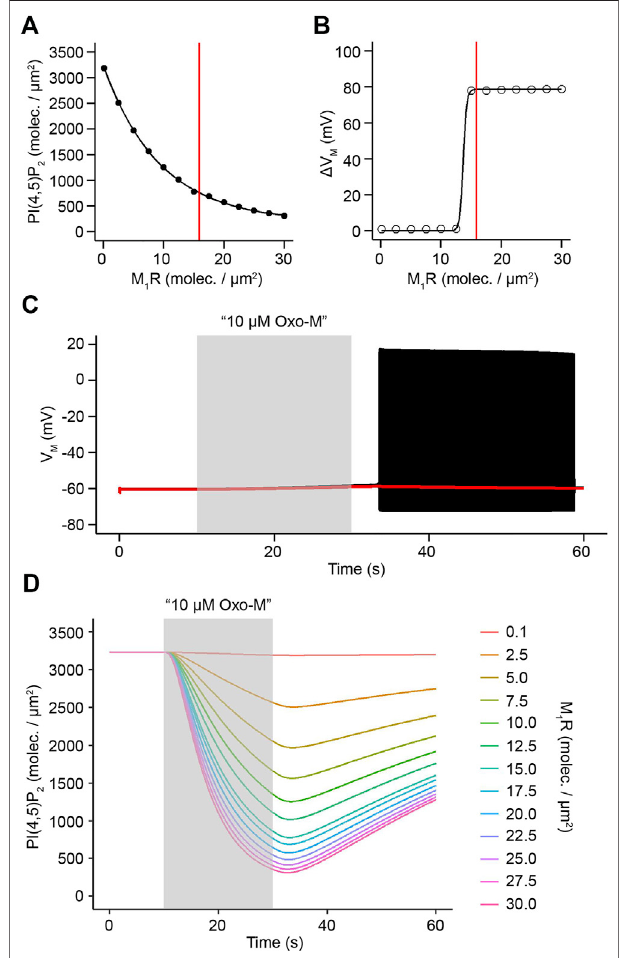
FIGURE 5 | Control of PI(4,5)P 2 depletion and action potential fi ring by M 1 R activity levels. (A) . PI(4,5)P 2 densities after activation of varying densities of M 1 R by 10 μ M Oxo-M for 20 s. Red line indicates experimentally determined M 1 R surface density of 15.87 receptors/ μ m 2 . (B) . Simulated maximum difference in membrane potential before and after activation of varying densities of M 1 R by 10 μ M Oxo-M for 20 s. Red line indicates experimentally determined M 1 R surface density of 15.87 receptors/ μ m 2 . (C) . Simulated membrane potential in response to an application of 10 μ M Oxo-M for 20 s at a M 1 R density of 12 receptors/ μ m 2 (red trace) or a density of 16 receptors/ μ m 2 (black trace). (D) . Time courses of PI(4,5)P 2 levels in response to a virtual application of 10 μ M Oxo-M for 20 s at indicated densities of M 1